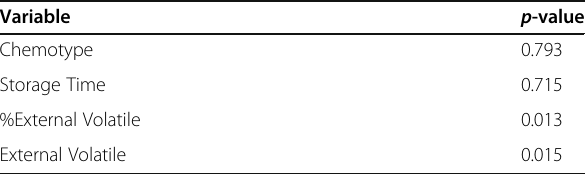
Table 4 Resulting p -values from ANOVA models evaluating the impact of each variable on the system ’ s effectiveness. A p -value of < 0.05 is considered statistically